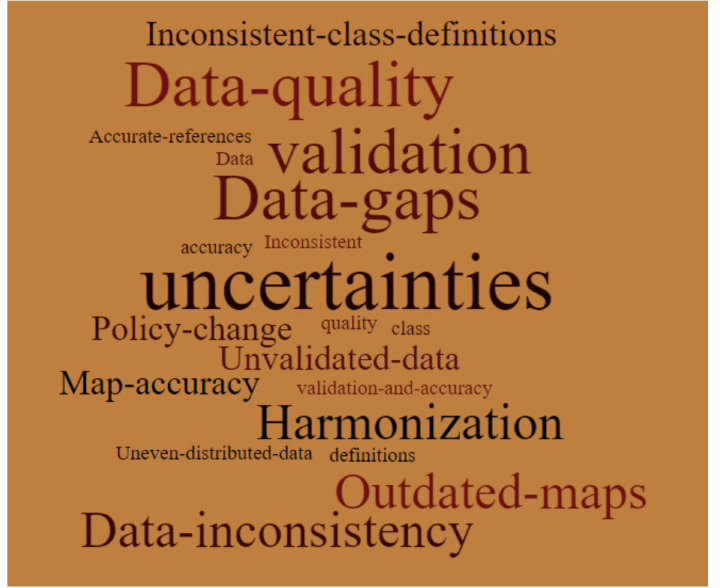
Figure 5. Showing knowledge gaps associated with Land-use and